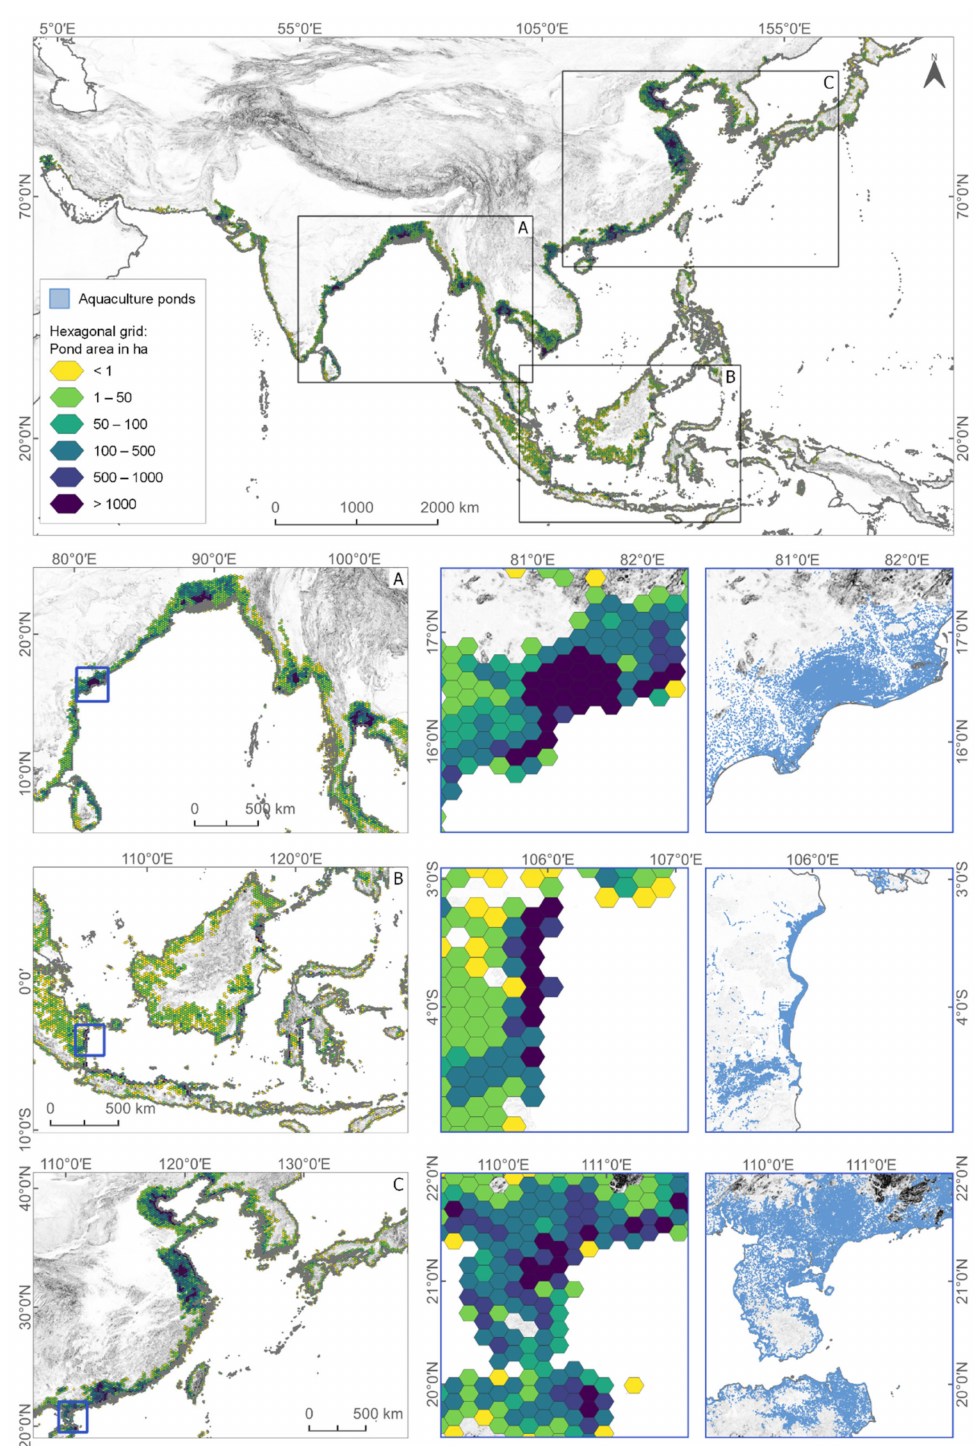
Figure 15. Pond aquaculture summarized into a 5 km hexagon grid vector dataset (interlocking hexagon cells with a side length of 5 km and an area of ~65 km 2 ). Area of aquaculture ponds per hexagon (area of ponds in ha) for the entire coastal zone of Asia. Top: Overview with three subregions and corresponding coastal spots (blue boxes): ( A ) South Asia with a focus on the Krishna River Delta and Godavari River Delta, India; ( B ) Southeast Asia with a focus on Lampung Province, Sumatra, Indonesia; ( C ) East Asia with a focus on Qiongzhou Strait between Leizhou Peninsula and Hainan Island,